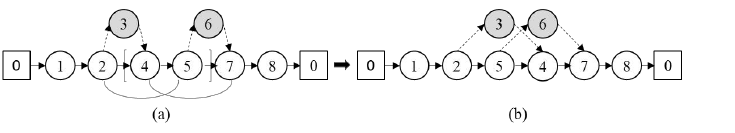
Figure 8. An example of an invalid TwoOpt move applied to the graph in ( a ), where origin nodes 2 and 5 are launch nodes and their destination nodes 4 and 7 are rendezvous nodes, resulting in an invalid tour in ( b ).